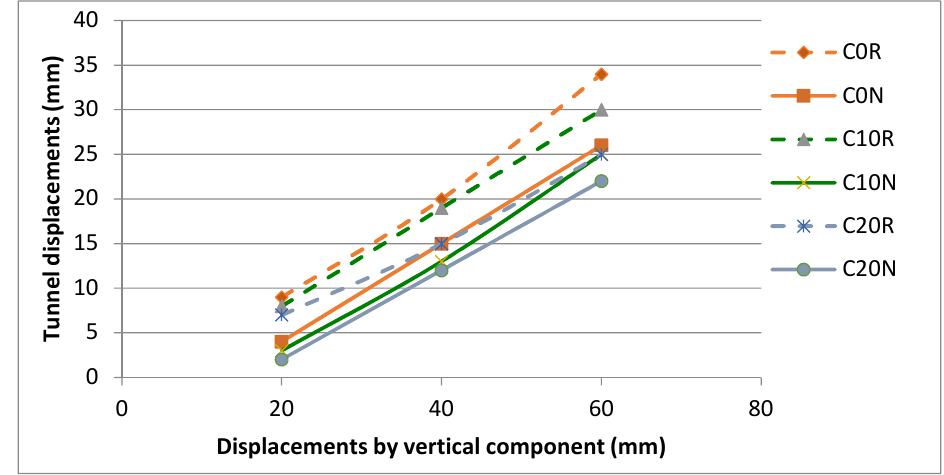
Figure 7. The effect of cohesion in reverse and normal faults. Figure 7. The e ff ect of cohesion in reverse and normal